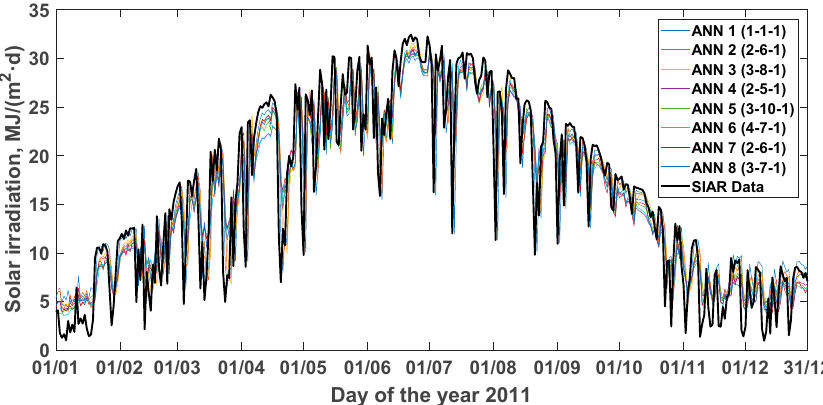
Figure 5. Simulations results of horizontal daily global solar irradiation the day after (MJ / (m 2 · d)), with the eight ANN evaluated models, compared with the variable values measured during 2011 (SIAR: agrometeorological station located in Mansilla Mayor, León, Spain). Table 1. Fitting achieved with the eight evaluated ANN models, between simulated values of horizontal daily solar irradiation the day after and measured values during 2011 at the agrometeorological station in Mansilla Mayor (León, Spain), considering in each model the hidden layer architecture that achieved the best predictions.